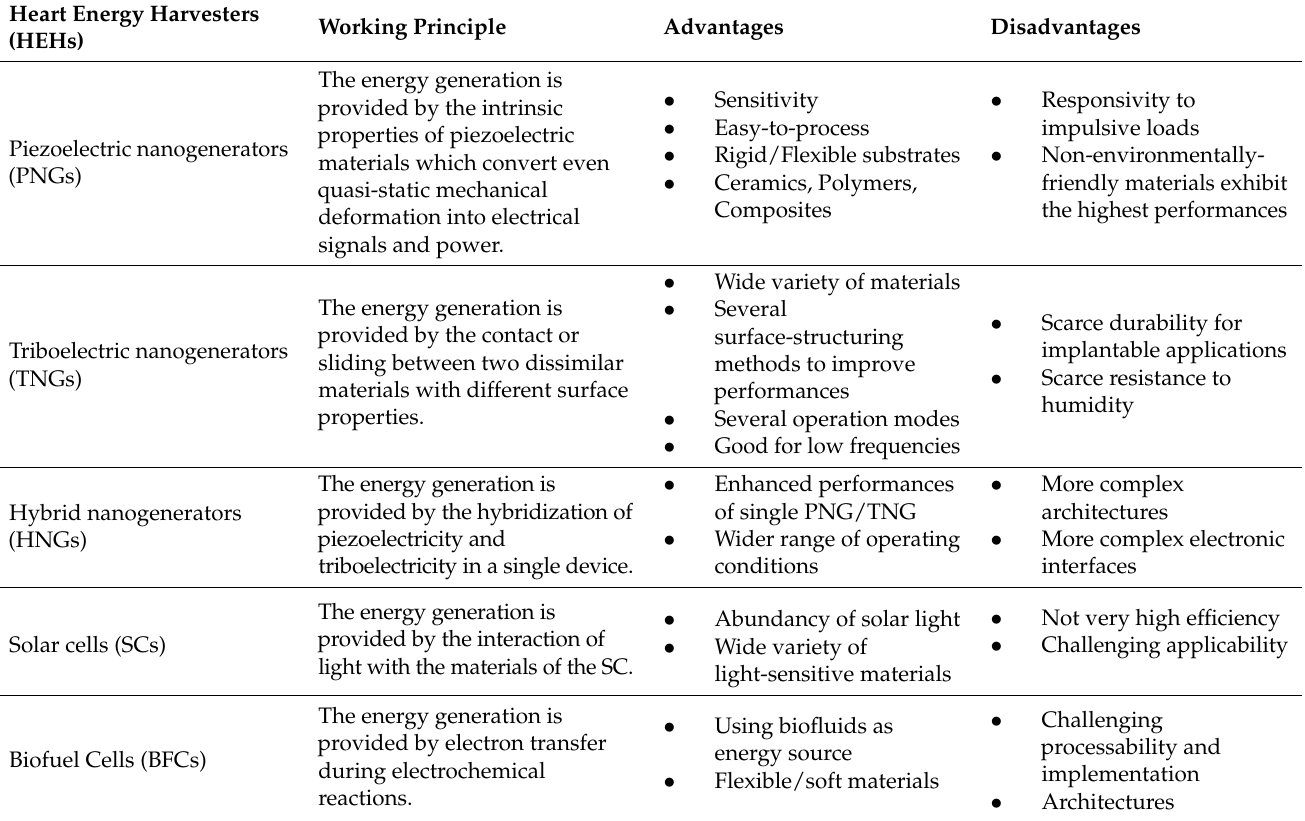
Table 1. Summary of the main working principles and advantages/disadvantages of the micro- devices for heart energy harvesting described in Section